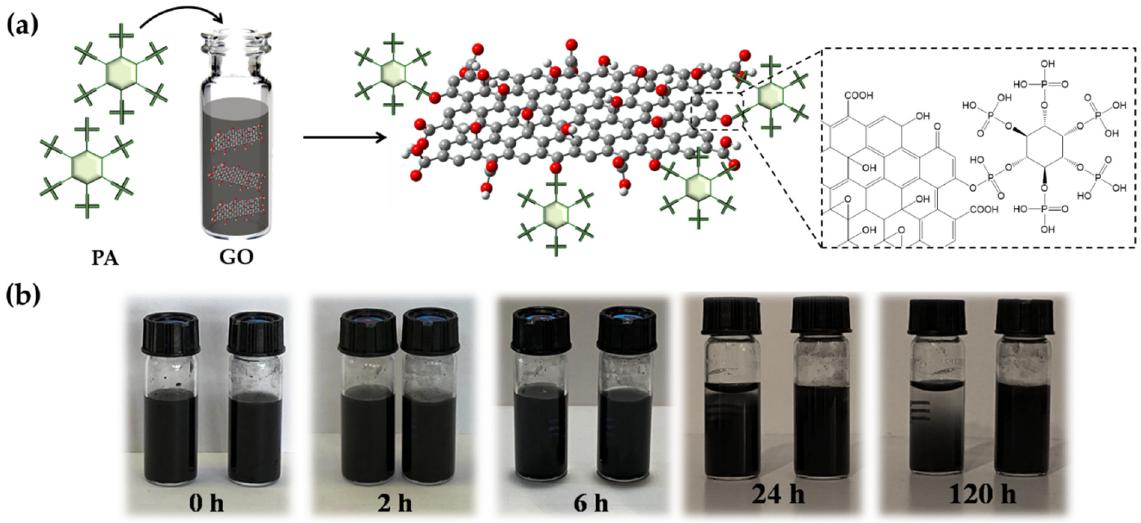
Figure 3. Probable reactions during PA intercalation of GO ( a ). Dispersion of GO ( left ) and GO-PA ( right ) ( b ) in water after various storage periods.